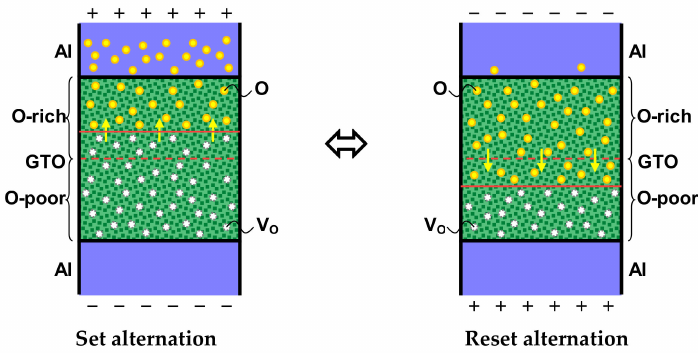
Figure 5. Operating mechanism of the memristive